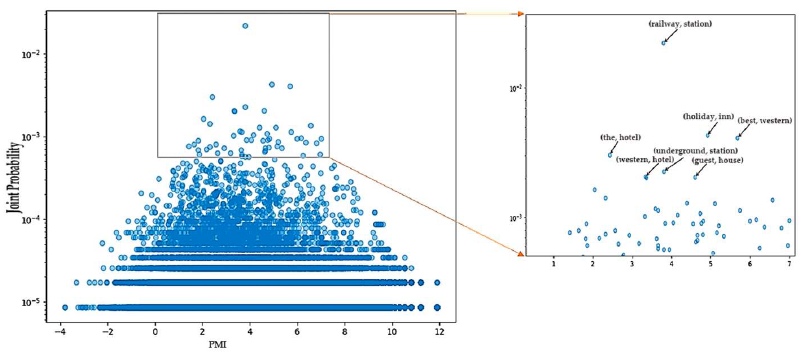
Figure 9. Scatterplot of word-pair frequency and value of pointwise mutual information.